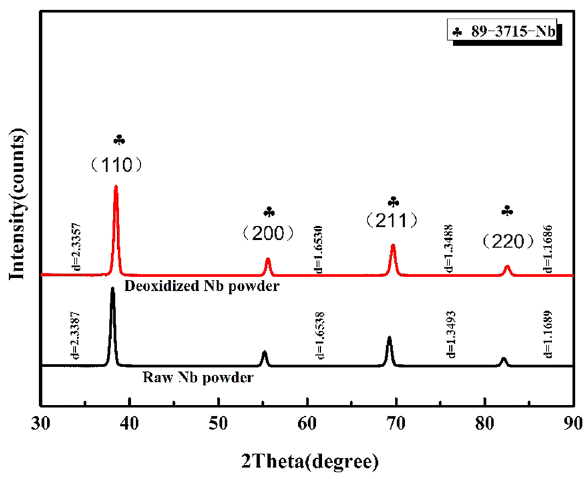
Figure 12. XRD diffraction pattern of niobium powder before and after deoxidisation.